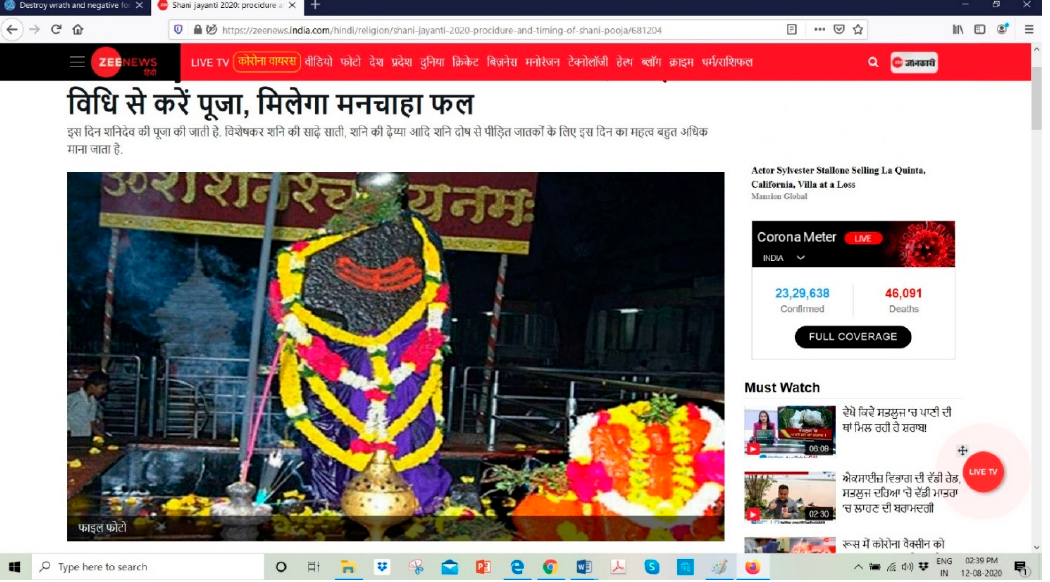
Figure 2. Aniconic Shani from Shingnapur Shanidev Temple. Source: Zee News.